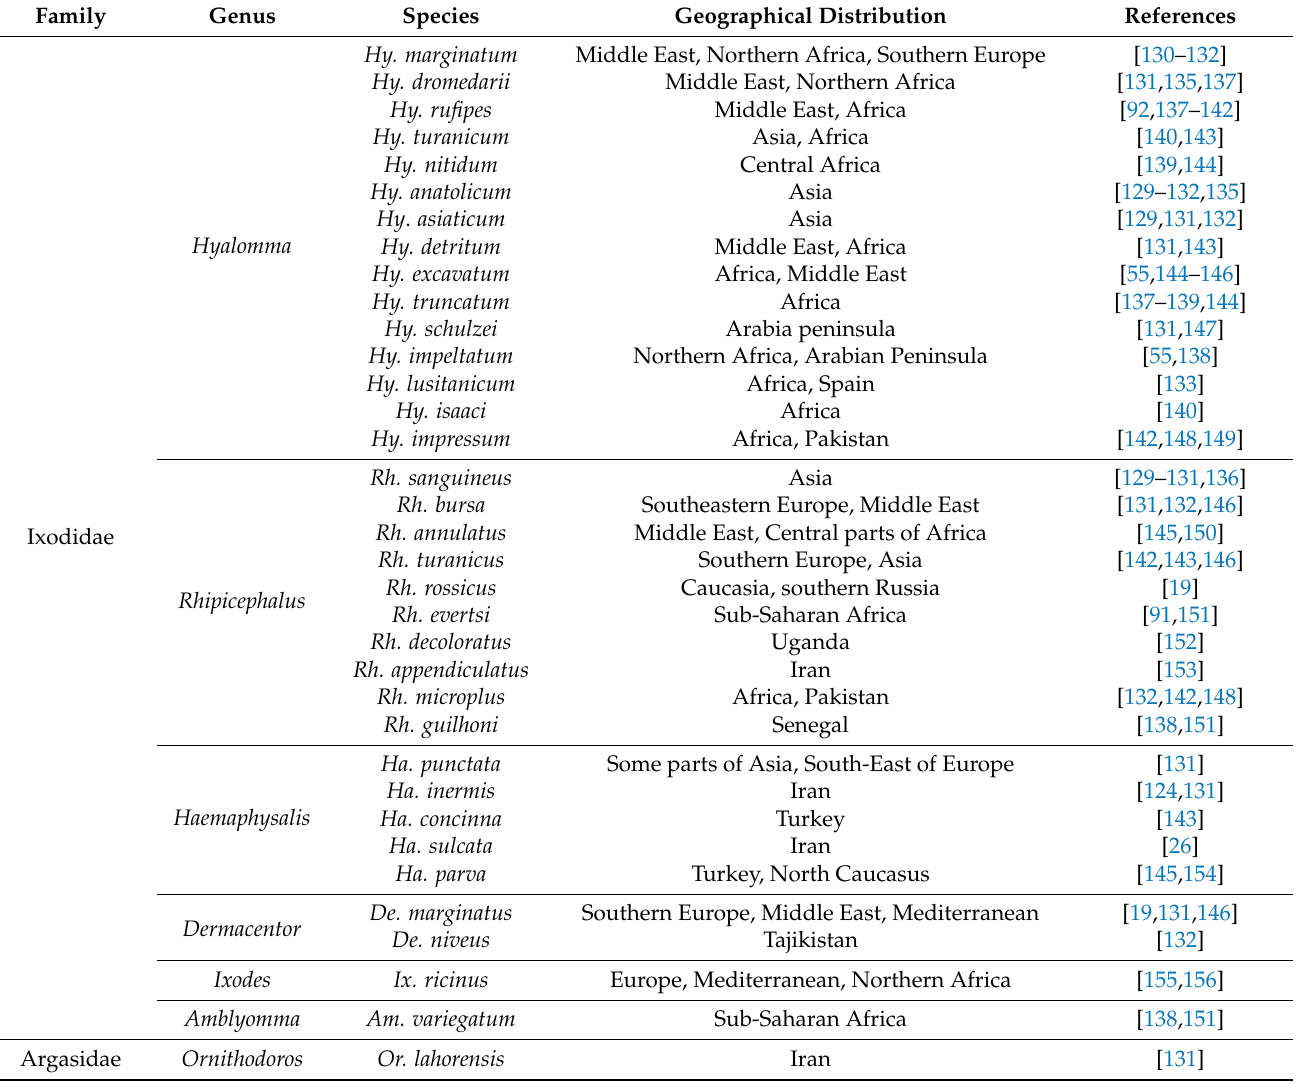
Table 1. A list of tick species that have been confirmed CCHFV-positive in different